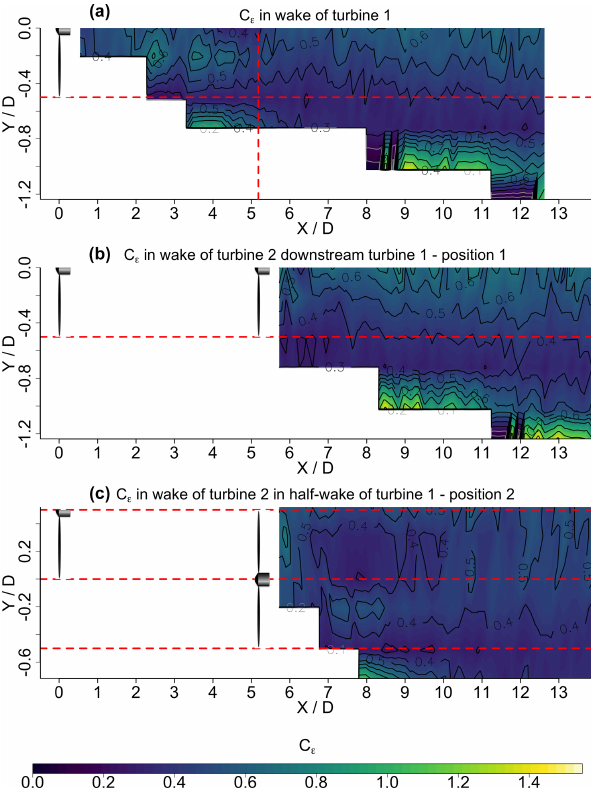
Figure 10. Interpolated surface plot of the downstream evolution of C ε for the three different inflow conditions: (a) turbine 1 – lam- inar inflow, (b) turbine 2 mid – turbulent, and (c) turbine 2 side – turbulent and intermittent. Outside of the turbulent wake, C ε is